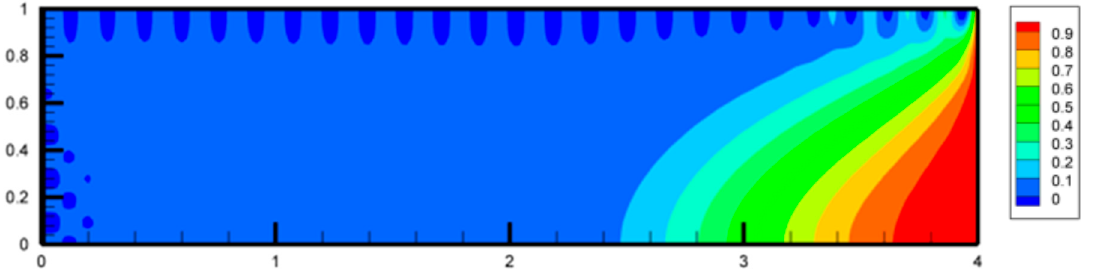
Figure 3. Non-physical oscillations related to the Gibbs phenomenon: the heterogeneous pure diffusive case evaluated with insufficient number of Fourier modes.